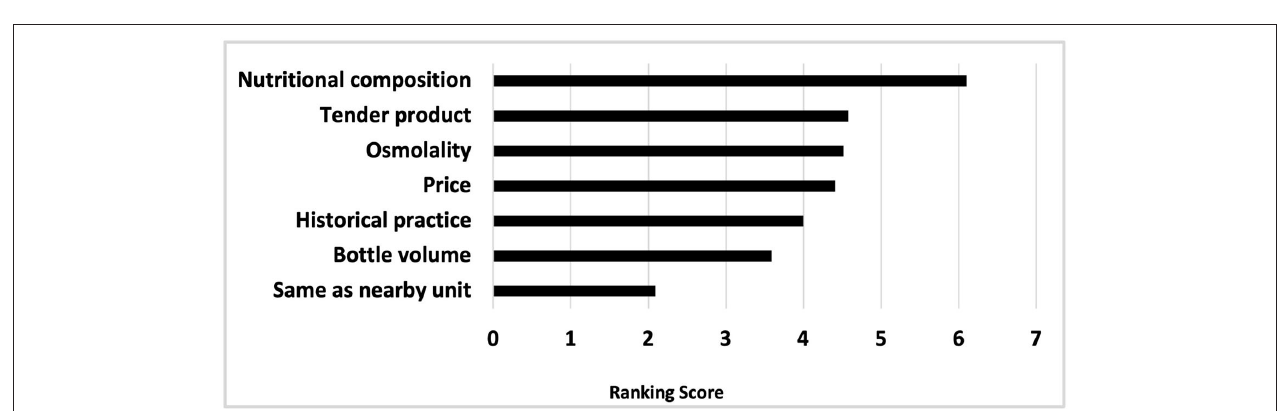
FIGURE 1 | Reasons guiding preterm formula choice, ranked in order of